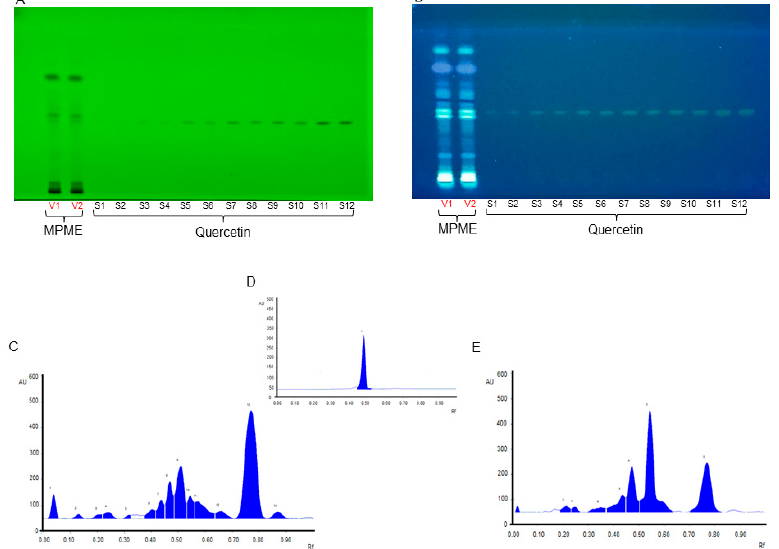
Figure 1 . High-performance thin-layer chromatography (HPTLC) chromatoplate of methanolic heartwood extract of Pterocarpus marsupium (MPME) (V1-V2) and Quercetin (S1-S12) under 254 nm ( A ) and at 366 nm ( B ). HPTLC chromatogram of MPME scanned at UV 254 nm ( C ), HPTLC chromatogram of Quercetin scanned at UV 254 nm ( D ), and HPTLC chromatogram of MPME scanned at UV 366 nm ( E ).